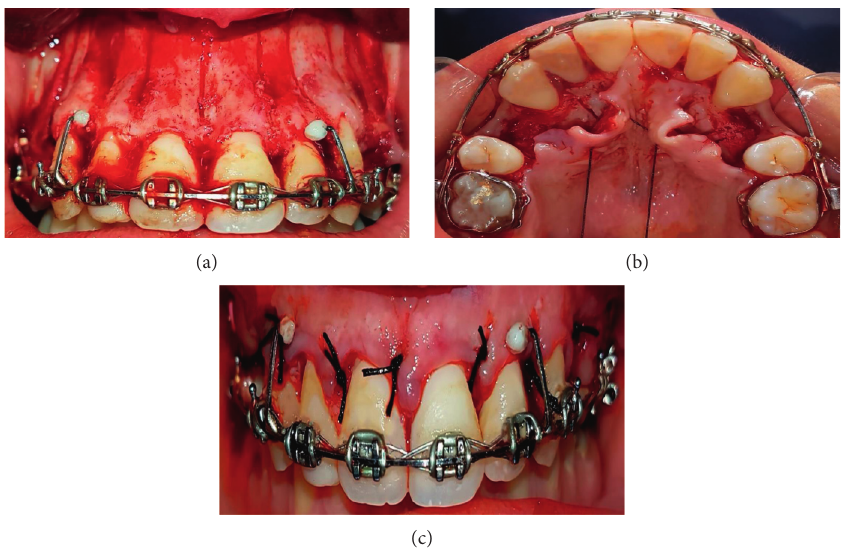
Figure 3: The traditional corticotomy from the buccal view (a) from the palatal view (b) and the surgical flap suturing (c).